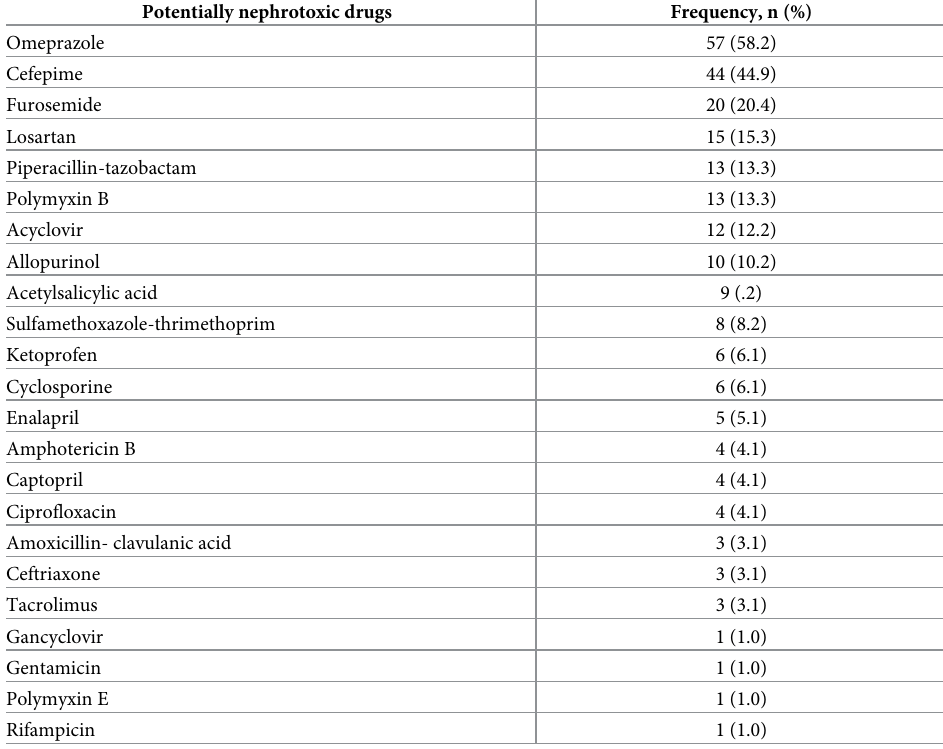
Table 2. Frequency of potentially nephrotoxic drugs used concomitantly with vancomycin in non-critically ill patients (n =